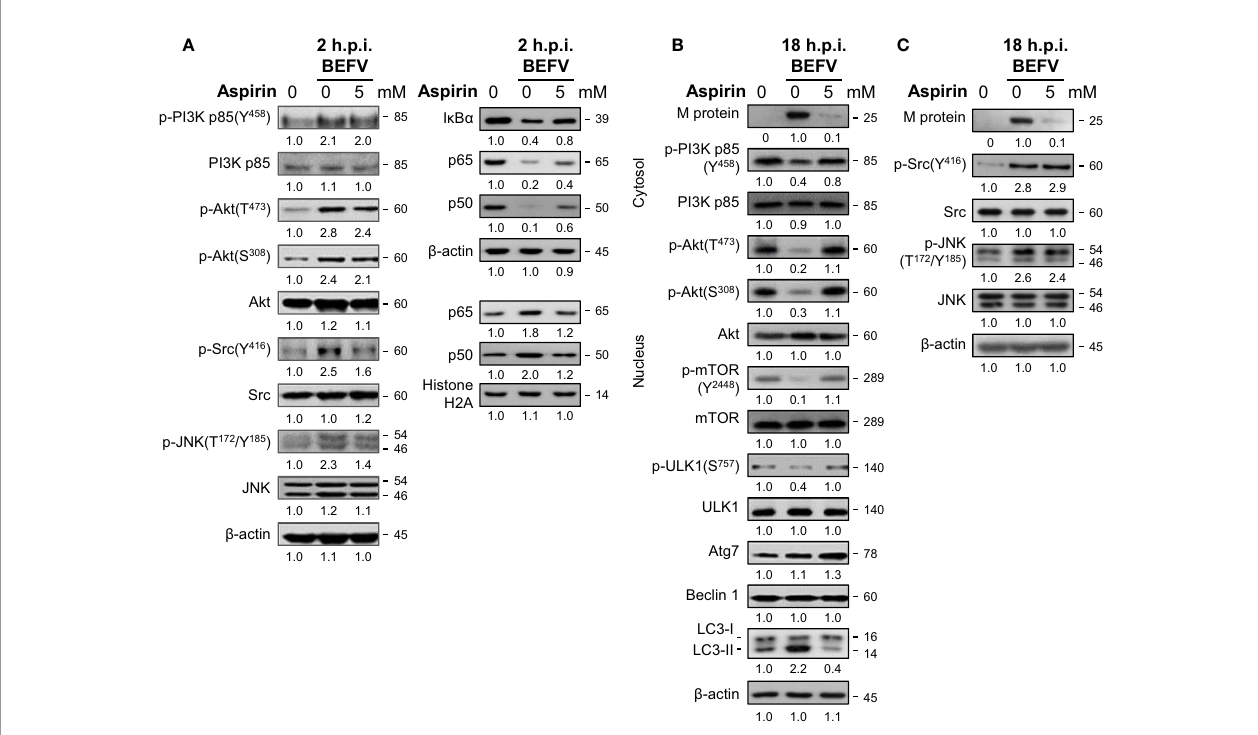
FIGURE 6 | Aspirin suppresses the BEFV-activated Src/JNK/AP-1 pathway at the early stage and reverses the BEFV-inactivated PI3K/Akt/mTOR pathway at late stage. MDBK cells were pretreated with or without aspirin (5 mM), respectively for 30 min, followed by infection with BEFV at an MOI of 1 for 2 hpi (A) and 18 hpi (B, C) . The cell lysates or cytosolic and nuclear fraction were collected at the indicated time points and subjected to immunoblotting with the respective antibodies. The levels of indicated proteins in the mock control group were considered onefold. The activation and inactivation folds indicated below each lane were normalized against values for the mock control group. Protein levels were normalized to those for b ‐ actin. Signals in all Western blots were quanti fi ed with ImageJ software. All experiments were conducted in three independent experiments. The predicted size of each protein was labeled at the right-hand side in